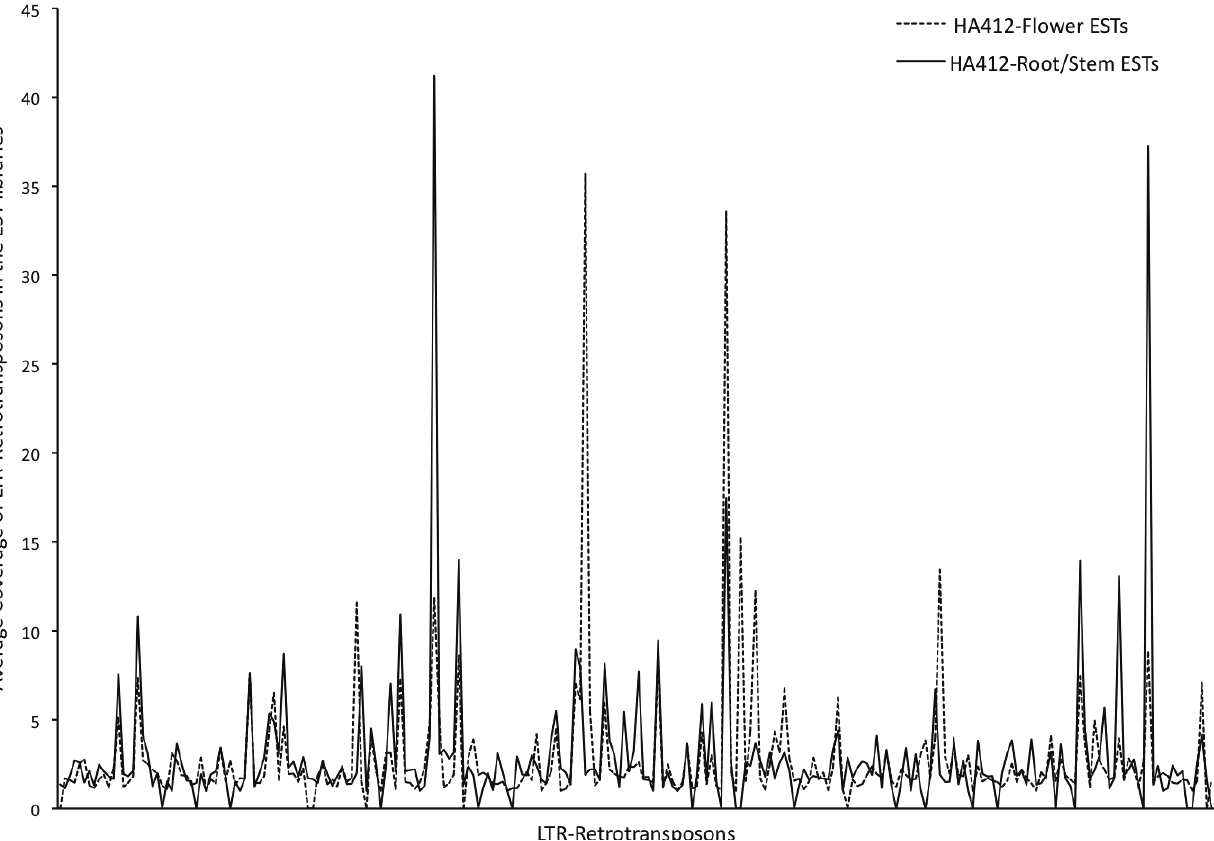
Figure 7. Differential expression of LTR-retrotransposons in the vegetative and reproductive tissues as determined by the average coverage of LTR-RTs in the HA412 flower and root-stem RNA-seq